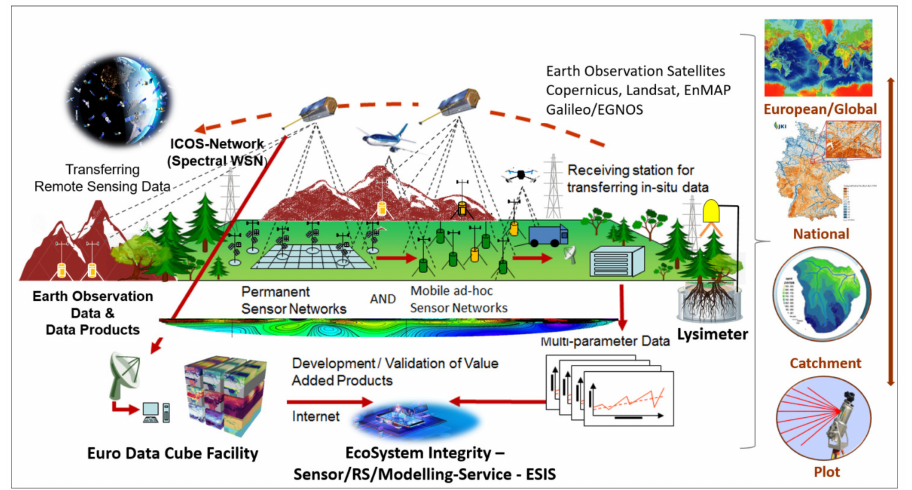
Figure 18. Linking in situ/field-monitoring approaches with different RS platforms (high-frequency spectral wireless sensor networks, ICOS towers, drones, and air- and spaceborne sensors) for the comprehensive monitoring of the traits of geomorphology, geomorphodiversity, and biodiversity and their interactions, as well as improving the calibration and validation of remote sensing data (modified after Lausch et al.